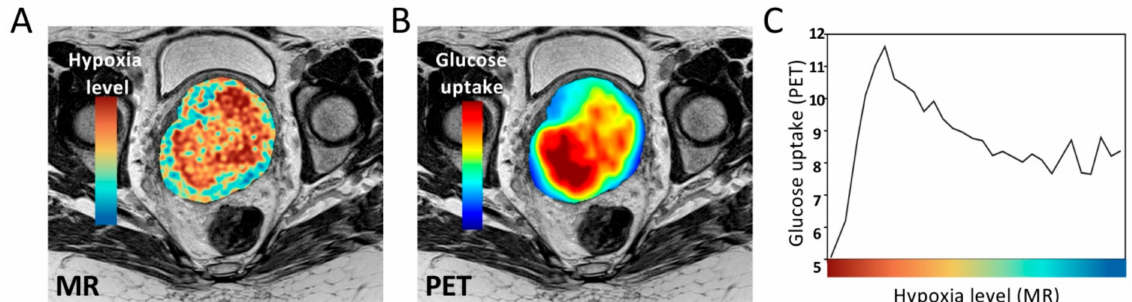
Figure 6. Glucose uptake at different hypoxia levels by combination of multimodality images. ( A ) Magnetic resonance (MR)-based hypoxia level image of a cervix tumor. ( B ) Glucose uptake in the same tumor by 18 F-fluorodeoxyglucose ( 18 F-FDG)-positron emission tomography (PET) imaging. ( C ) Glucose uptake as a function of hypoxia level based on a voxel-by-voxel analysis of the co-registered images in ( A , B ). The hypoxia levels were divided into 20 sublevels, and the mean PET signal of each sublevel is plotted. ( A , B ) The hypoxia level and glucose uptake images are overlaid on T 2 weighted images of the pelvis. ( A – C ) Hypoxia levels are indicated by the color code, with approximate oxygen concentrations (% O 2 ) and tensions (mmHg) provided by the x -axis in Figure